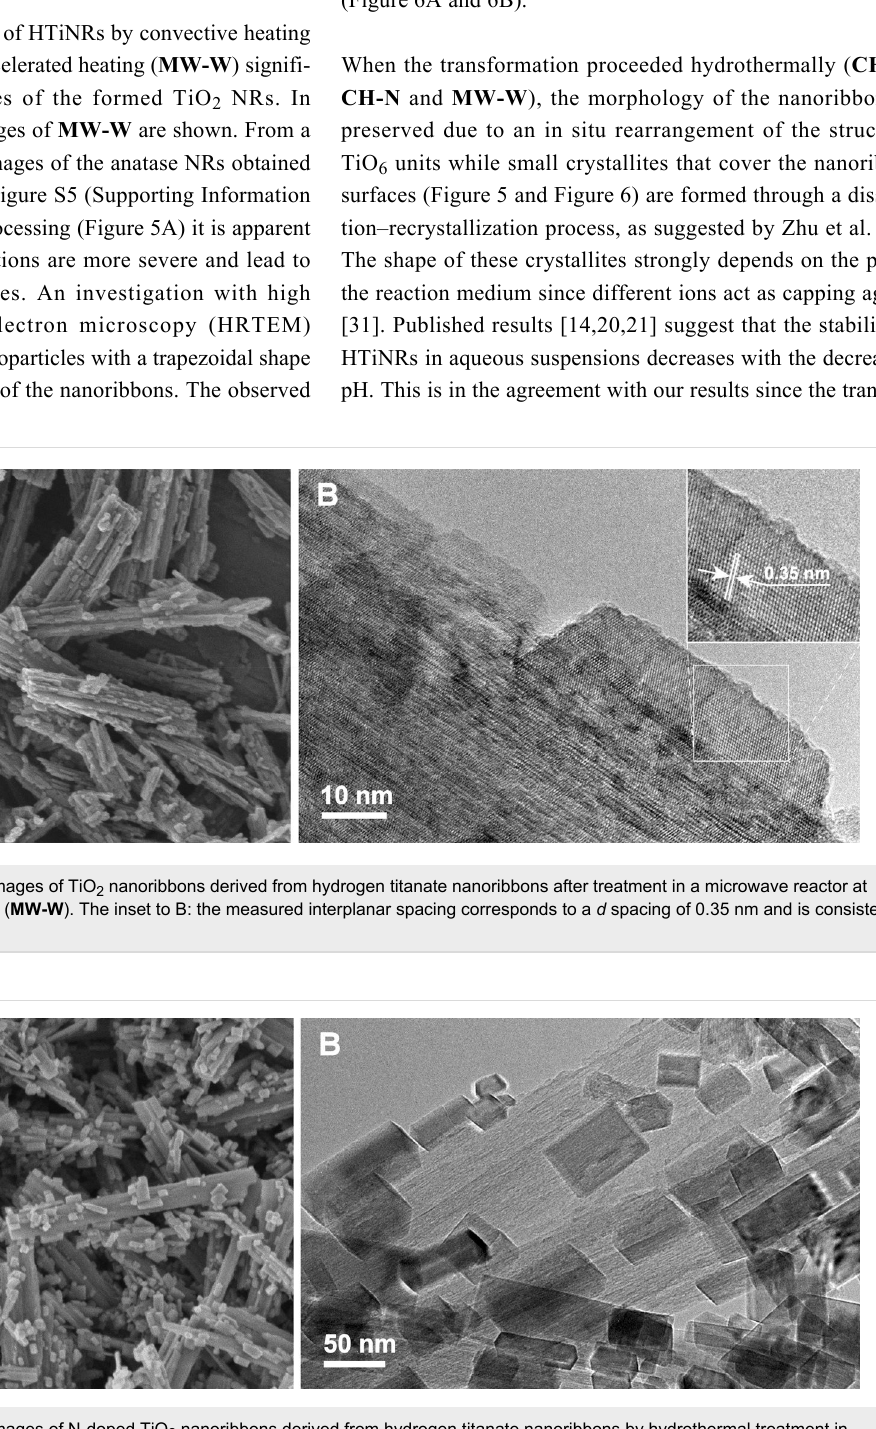
Figure 6: A) SEM and B) TEM images of N-doped TiO 2 nanoribbons derived from hydrogen titanate nanoribbons by hydrothermal treatment in 0.5 M NH 3 (aq) at 160 °C for 10